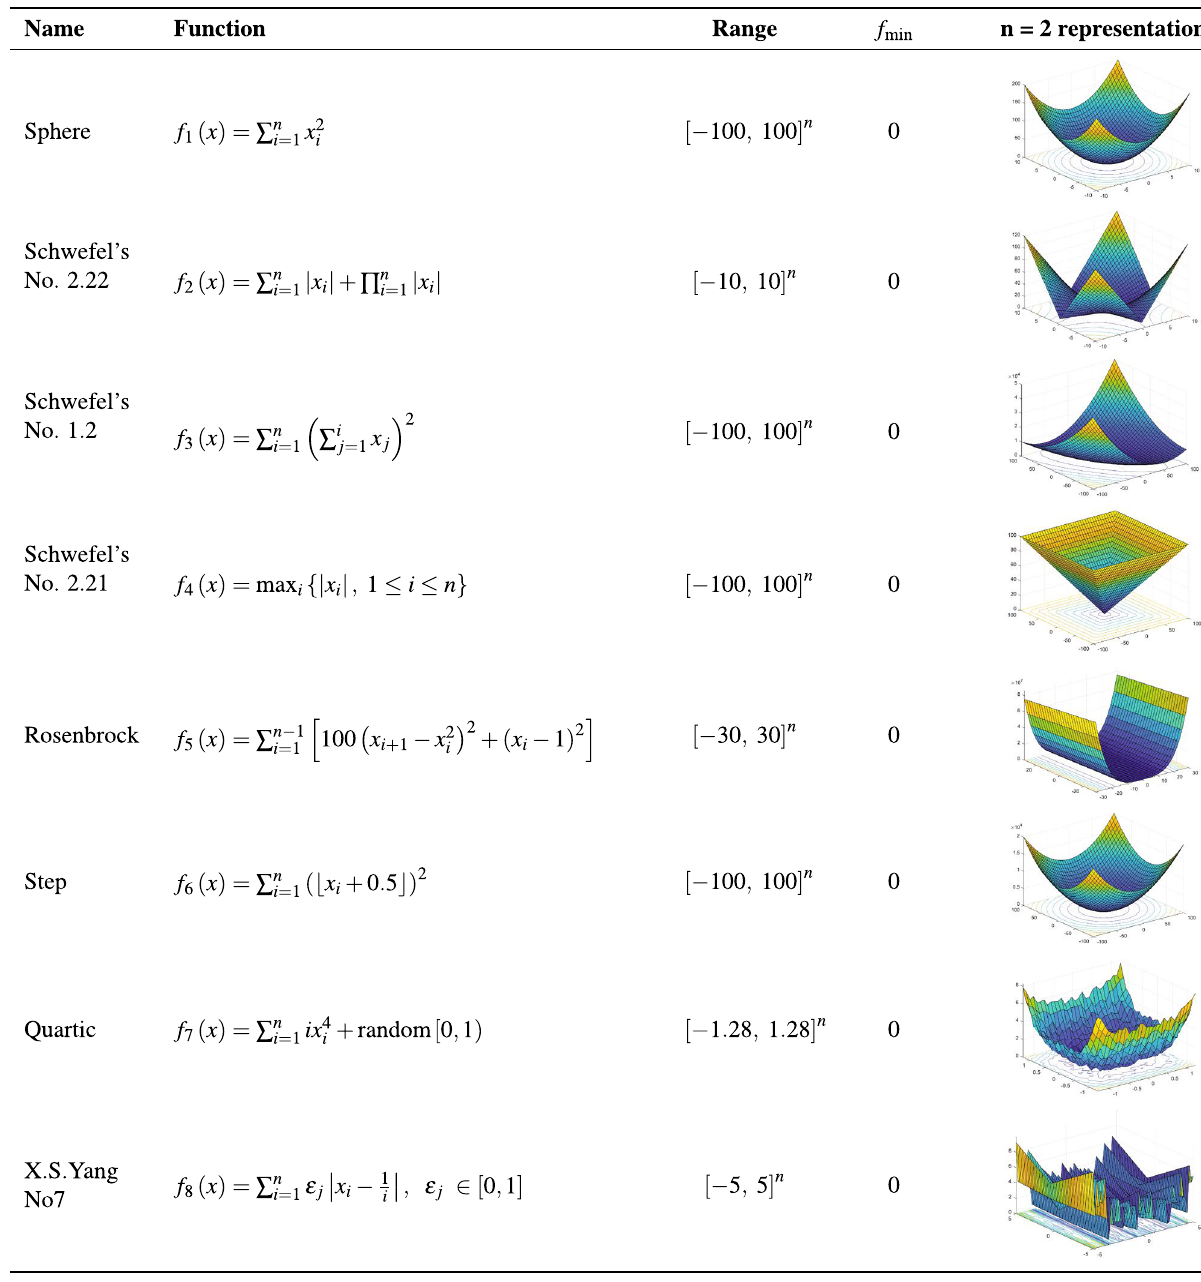
Table 7. Unimodal benchmark